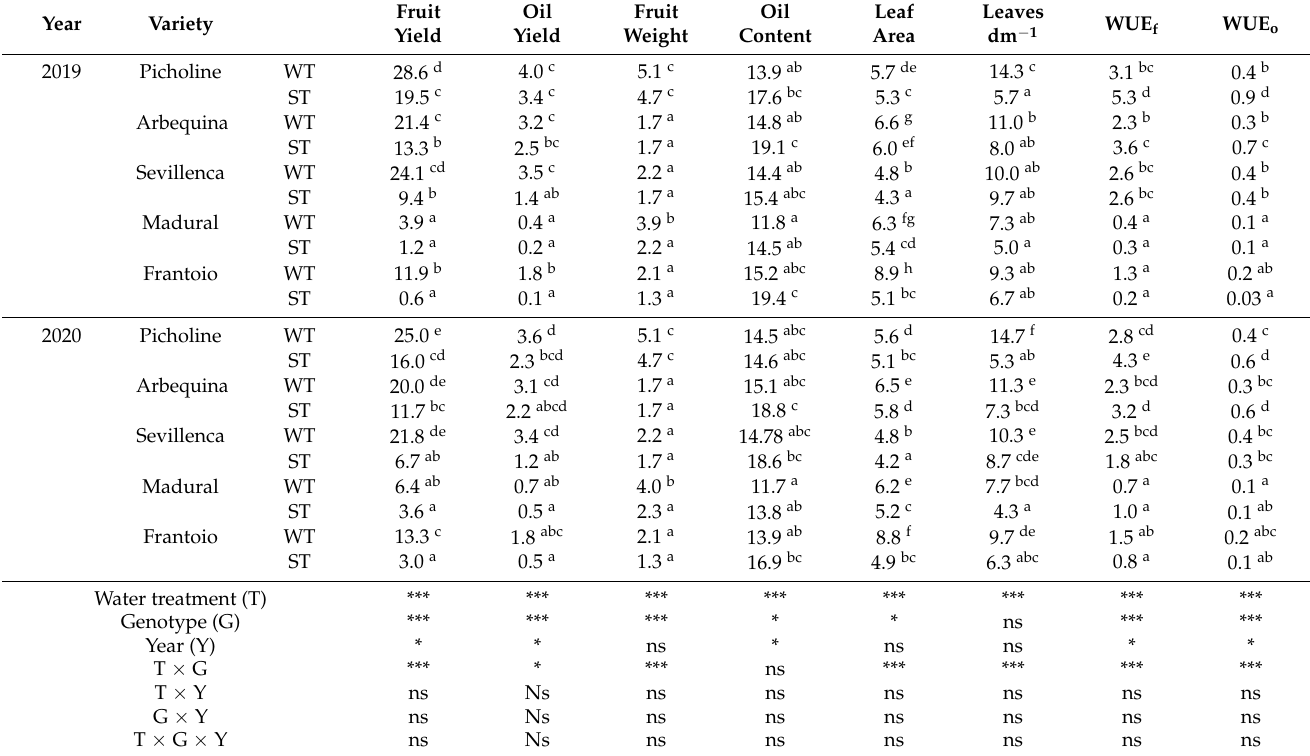
Table 4. Yield (kg tree − 1 ), fruit weight (g), oil content (% fw ), leaf area (cm 2 ), leafing intensity (leaves dm − 1 ), and water use efficiency for fruit (WUE f , kg m − 3 ) and oil (WUE o , kg m − 3 ) production per tree in watered trees (WT) and stressed (ST) trees of the studied olive varieties for the two experimental